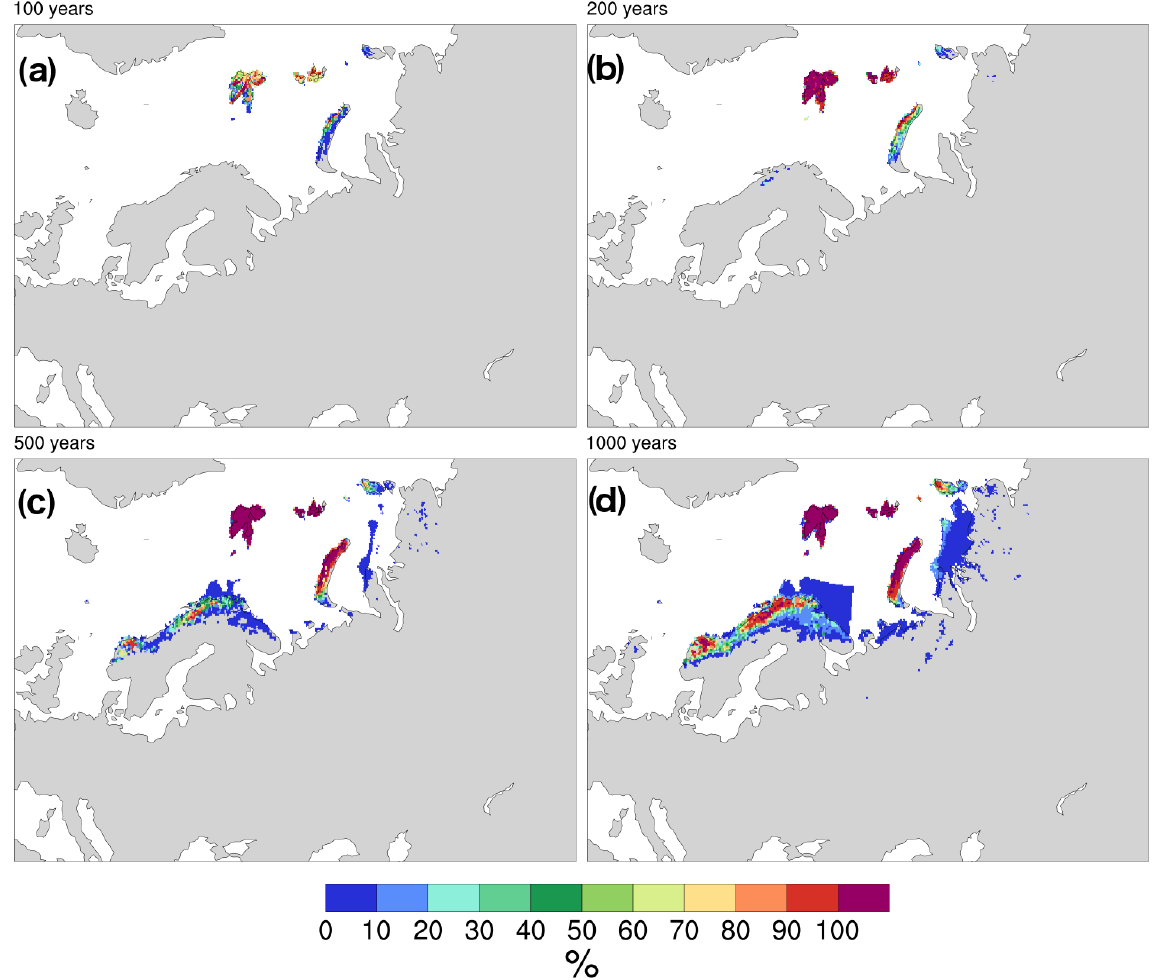
Figure 4. Percent of runs exhibiting ice cover in each grid cell for EA after (a) 100, (b) 200, (c) 500, and (d) 1000 years of